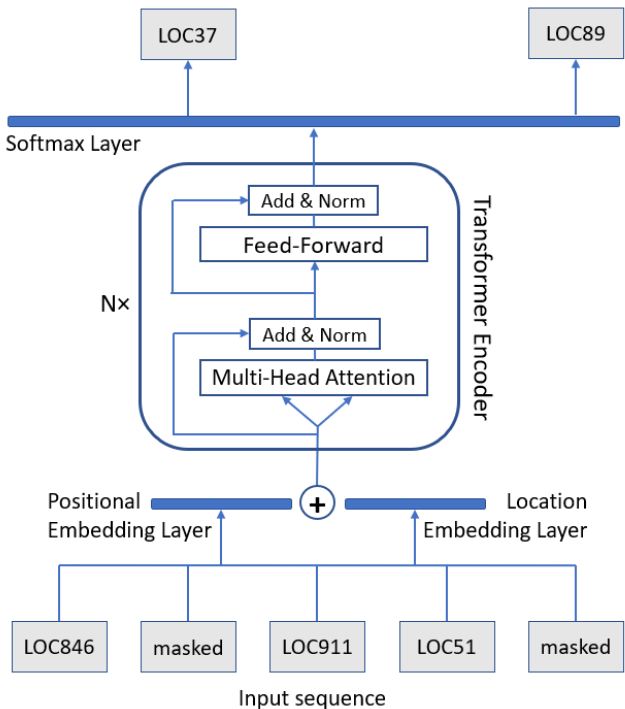
Figure 2. Visual representation of the TraceBERT model architecture.